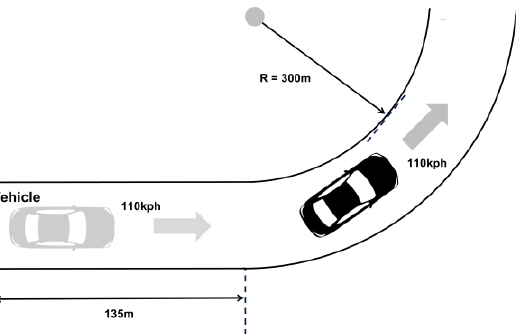
Figure 10. High-speed circle entry scenario. Electronics 2021 , 9 , x FOR PEER REVIEW